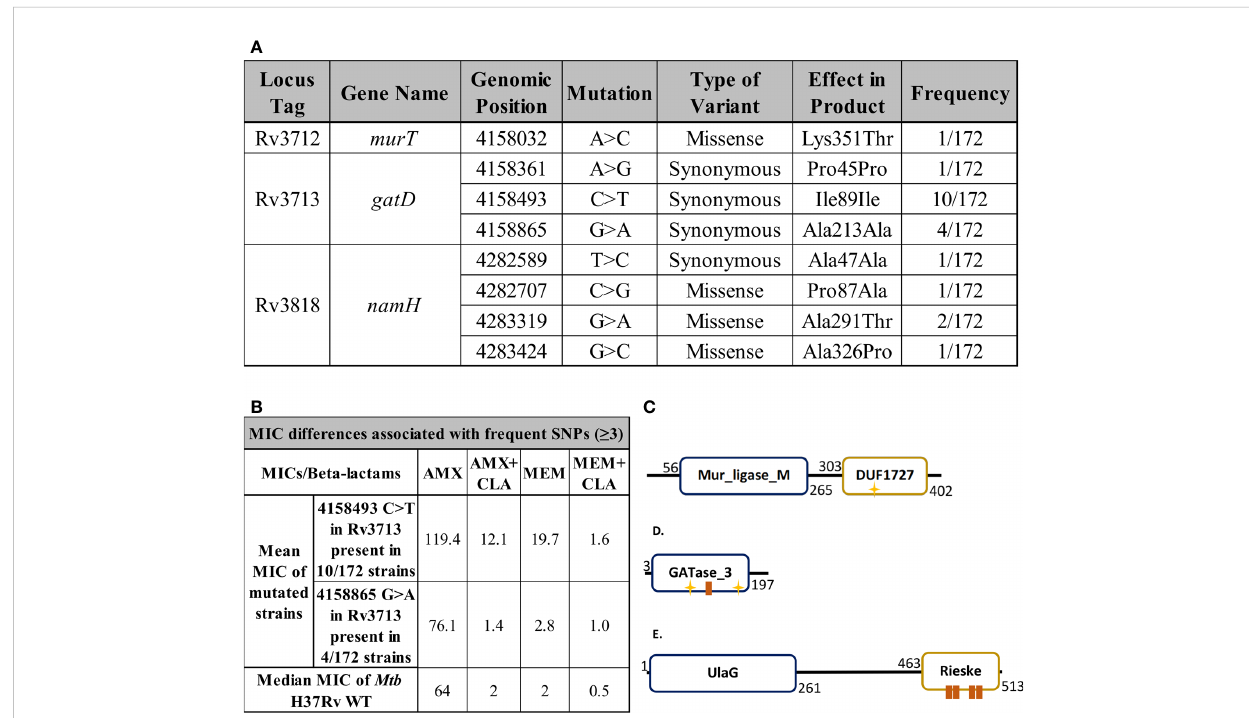
FIGURE 9 Single nucleotide polymorphism (SNP) detection and MIC assays. (A) Single nucleotide polymorphisms found in the target genes murT , gatD or namH through the whole genome sequencing of 172 clinical strains of Mtb . Locus tags, gene names, products and positions refer to the H37Rv reference genome (AL123456.3). (B) Geometric mean MIC of clinical strains harbouring frequent single nucleotide polymorphisms (n ≥ 3) compared to the median MIC of Mtb H37Rv WT. (C-E) Protein structures were drawn based on data from the NCBI, Pfam, UniProt and PROSITE databases. The yellow stars represent active sites while the brown boxes represent binding sites. (C) The protein structure of MurT, comprising a central Mur ligase domain and the DUF1727 domain. The D349 residue present in the DUF1727 domain of MurT is important for the catalytic activity of GatD, being part of its catalytic triad. (D) The protein structure of GatD, comprising a GATase_3 domain, responsible for its catalytic glutamine amidotransferase activity (C94, H189). (E) The protein structure of NamH, comprising a beta-lactamase superfamily UlaG domain and a Rieske domain, associated with oxidoreductase